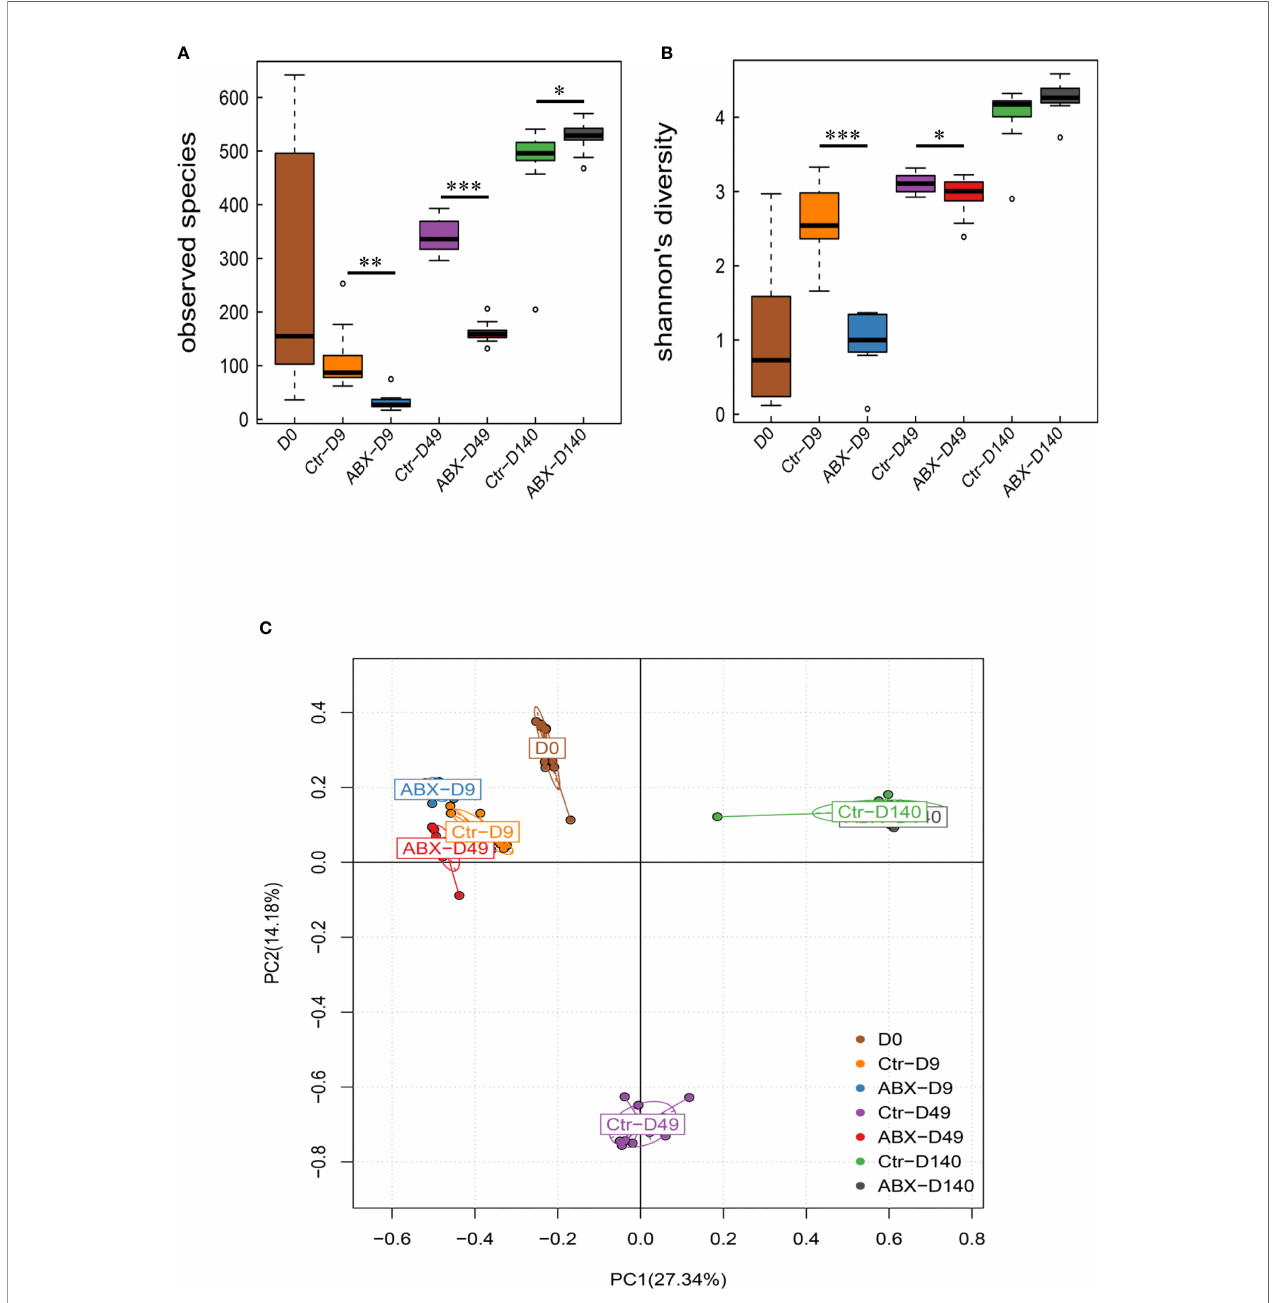
FIGURE 4 | Effects of antibiotic treatment on the diversity of the gut microbiota. (A) Differences in a -diversity between control (Ctr) and antibiotic-treated (ABX) chickens at different ages. (B) Differences in a -diversity between Ctr and ABX at different ages analyzed with the Shannon ’ s indices. (C) Differences in b -diversity between Ctr and ABX groups at different ages analyzed with principal component analysis. * p < 0.05, ** p < 0.01, *** p < 0.001; Wilcoxon rank-sum test. n ≥ 8 for each